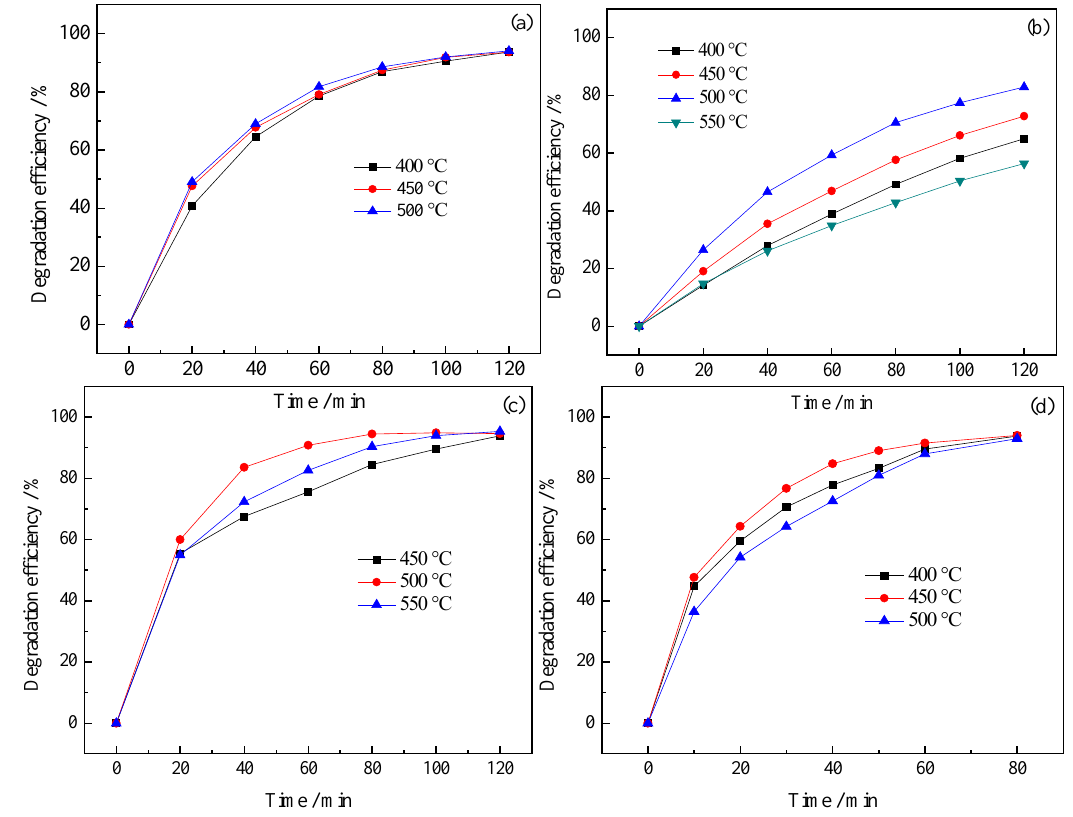
Figure 8. Effect of calcination temperatures on the photodegradation of BHA by RE/TiO 2 . ( a ) 0.75%La/TiO 2 ; ( b ) 0.20%Ce/TiO 2 ; ( c ) 0.70%Gd/TiO 2 ; ( d ) 0.50%Yb/TiO 2.